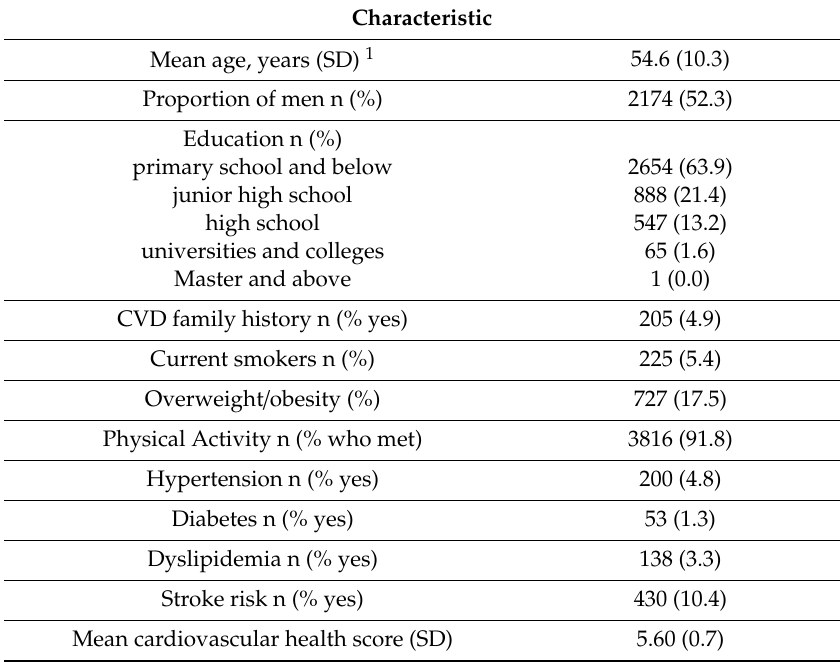
Table 2. Demographic and health profile of the study participants in Harbin,